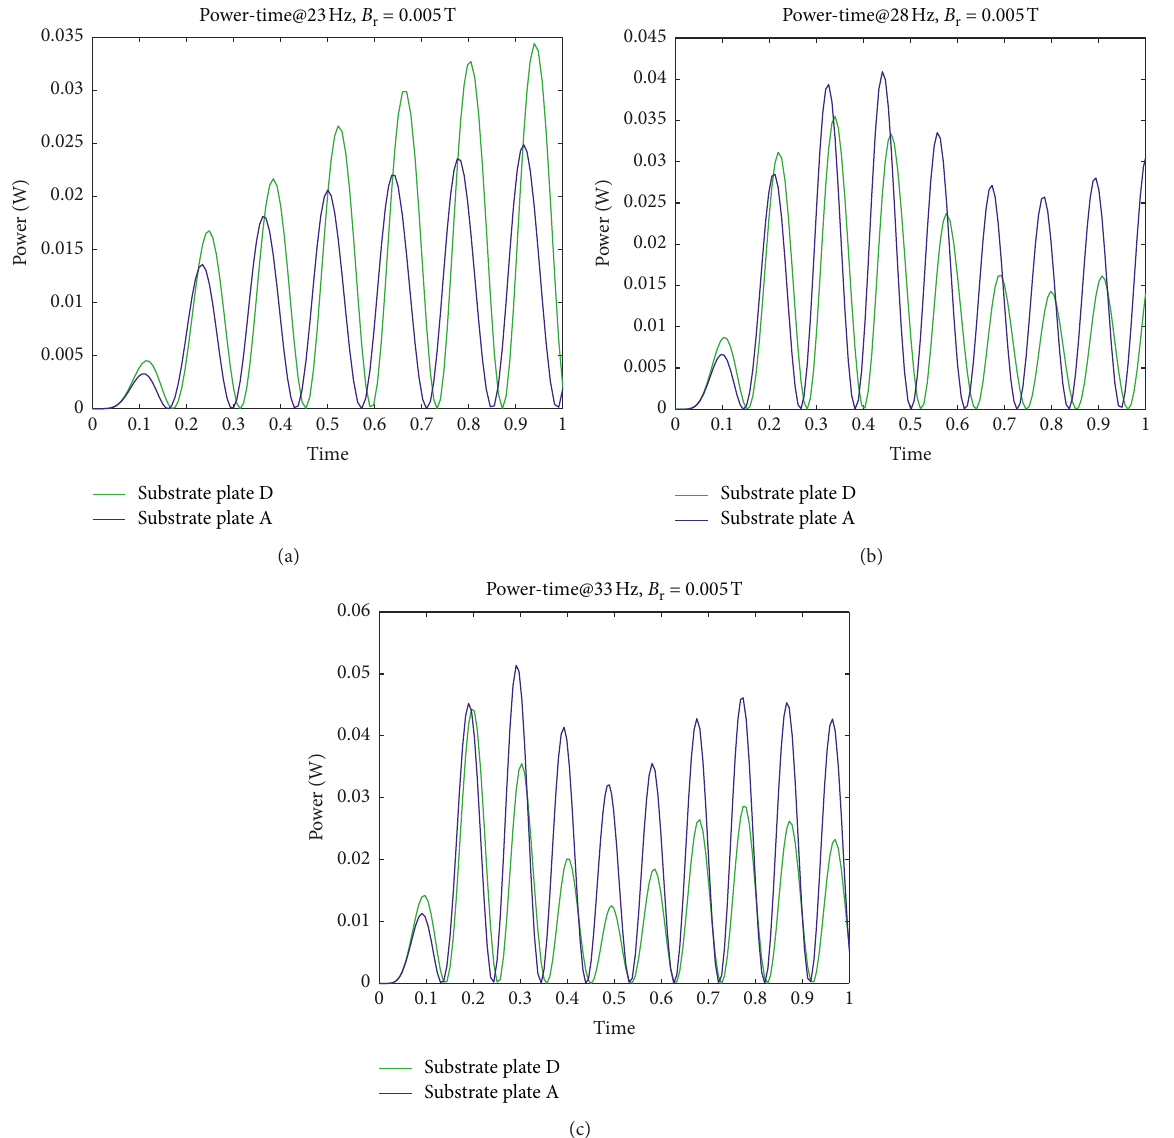
Figure 11: Power output in time history for the nonlinear EMM system: (a) 23Hz; (b) 28Hz; (c) 33